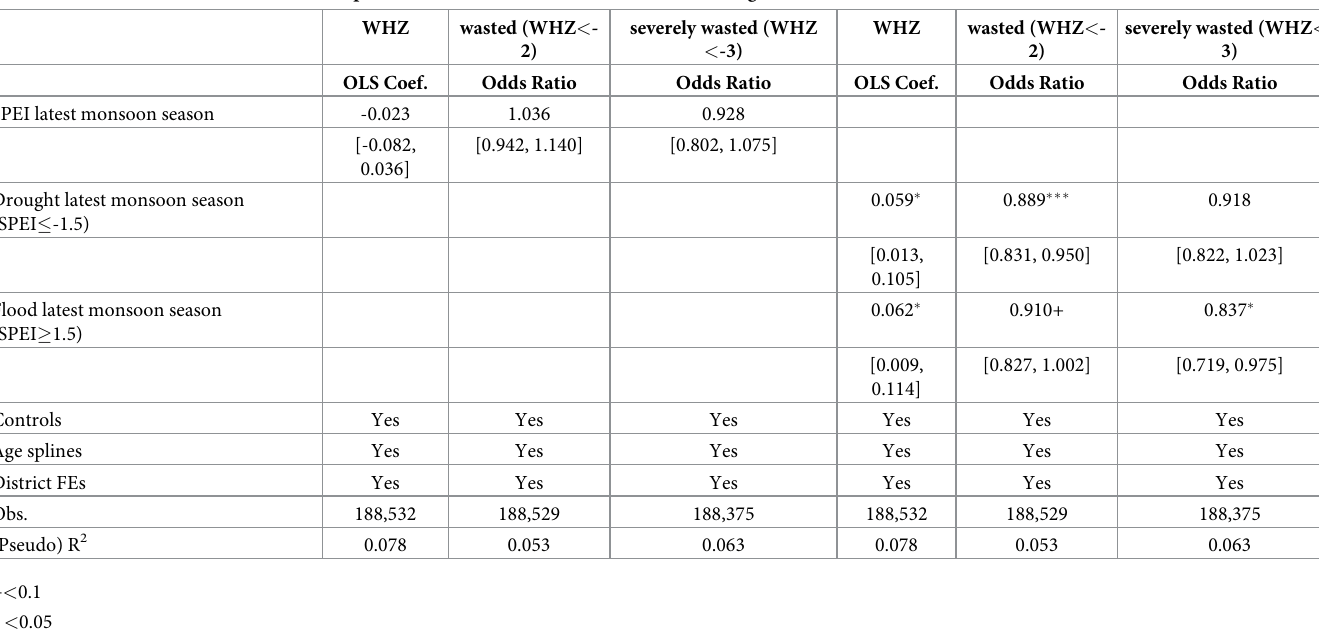
Table 5. Effects of monsoon season climate prior to interview on undernutrition, children aged 0–5.